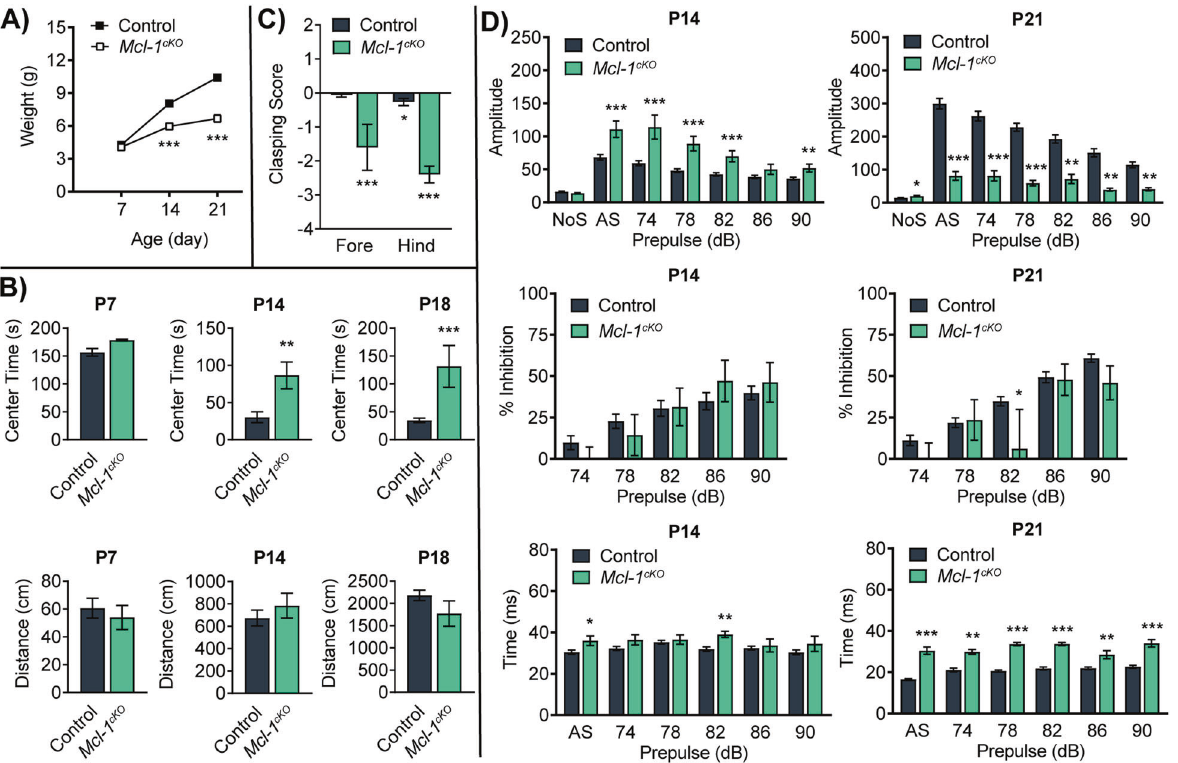
Fig. 2 Mcl-1 deletion causes progressive neurologic impairment. A Reduced weight gain in Mcl-1 cKO mice compared to controls. B Mcl-1 cKO mice show normal motor function at P7, with altered motor function by P14 and C increased hindlimb clasping at P18. D Mcl-1 cKO mice show increased startle in response to auditory stimuli at P14 and reduced elicited movement at P21. Amplitude was de fi ned as the de fl ection produced by a piezoelectric transducer in the assay and integrates the startle movements into a quanti fi able signal. Percent inhibition was calculated as 100 − [(response amplitude for prepulse stimulus and startle stimulus together/response amplitude for startle stimulus alone) × 100]. Time was de fi ned as the delay between acoustic stimulus and startle responses. *, **, and *** denote p < 0.05, p < 0.01, and p < 0.001 respectively, relative to